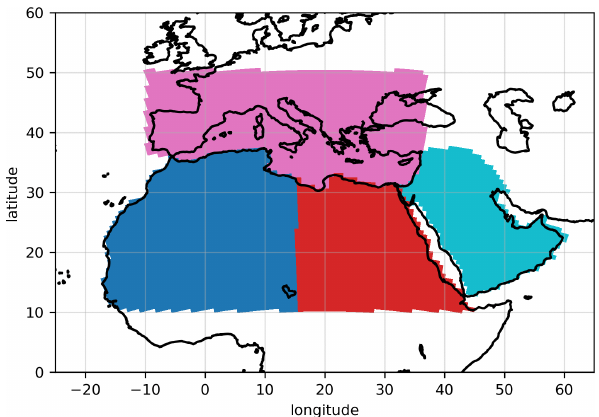
Figure B1. Definition of regions of Fig. 4. The Mediterranean re- gion is shown in pink, Western Sahara in blue, Eastern Sahara in red, and Arabian Peninsula in